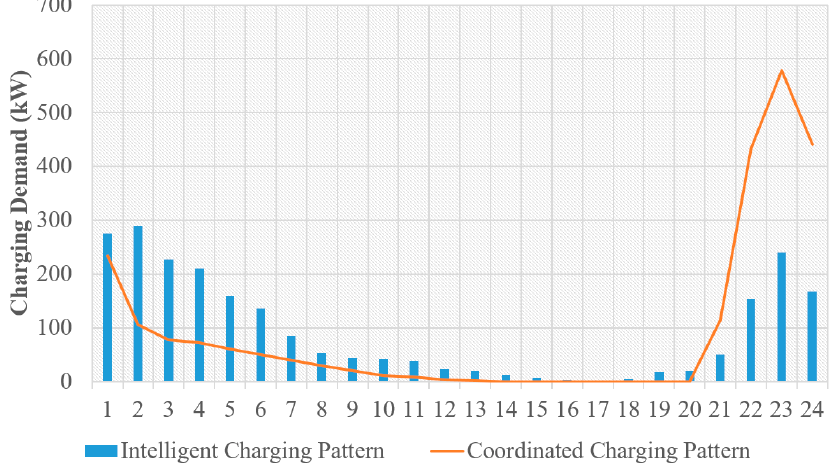
Figure 6. Comparative curves of coordinated and intelligent charging patterns.